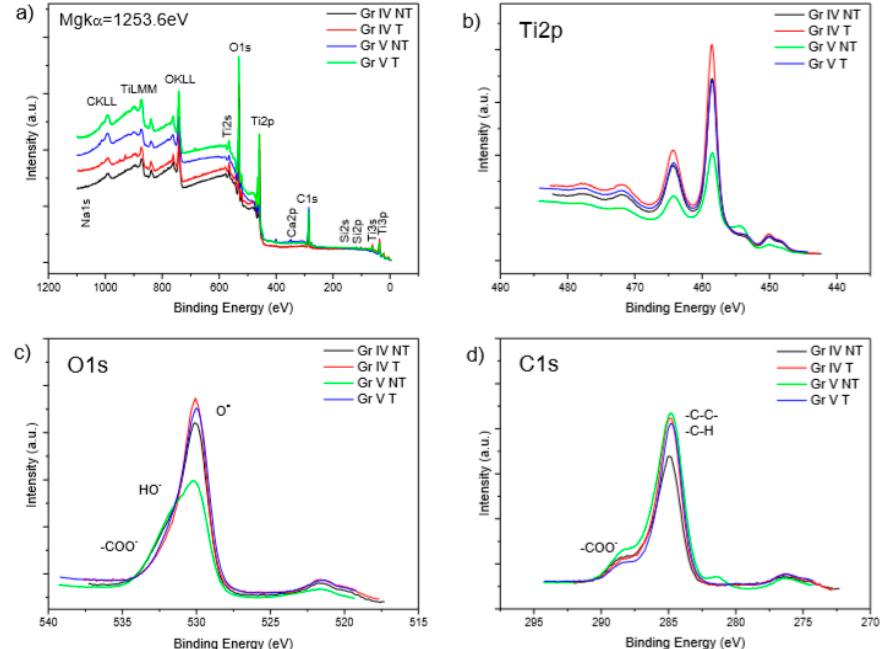
Figure 2. ( a ) General spectrum; ( b ) regions of Ti2p; ( c ) O1s; ( d ) C1s; grade IV untreated (TiIVNT) black line; grade IV treated (TiIVT) red line; grade V untreated (TiVNT) green line; and grade V treated (TiVT) blue line. Table 1. Element concentrations. TiIVT and TiIVNT: treated and untreated titanium grade IV discs; TiVT and TiNVT: treated and untreated titanium grade V discs.